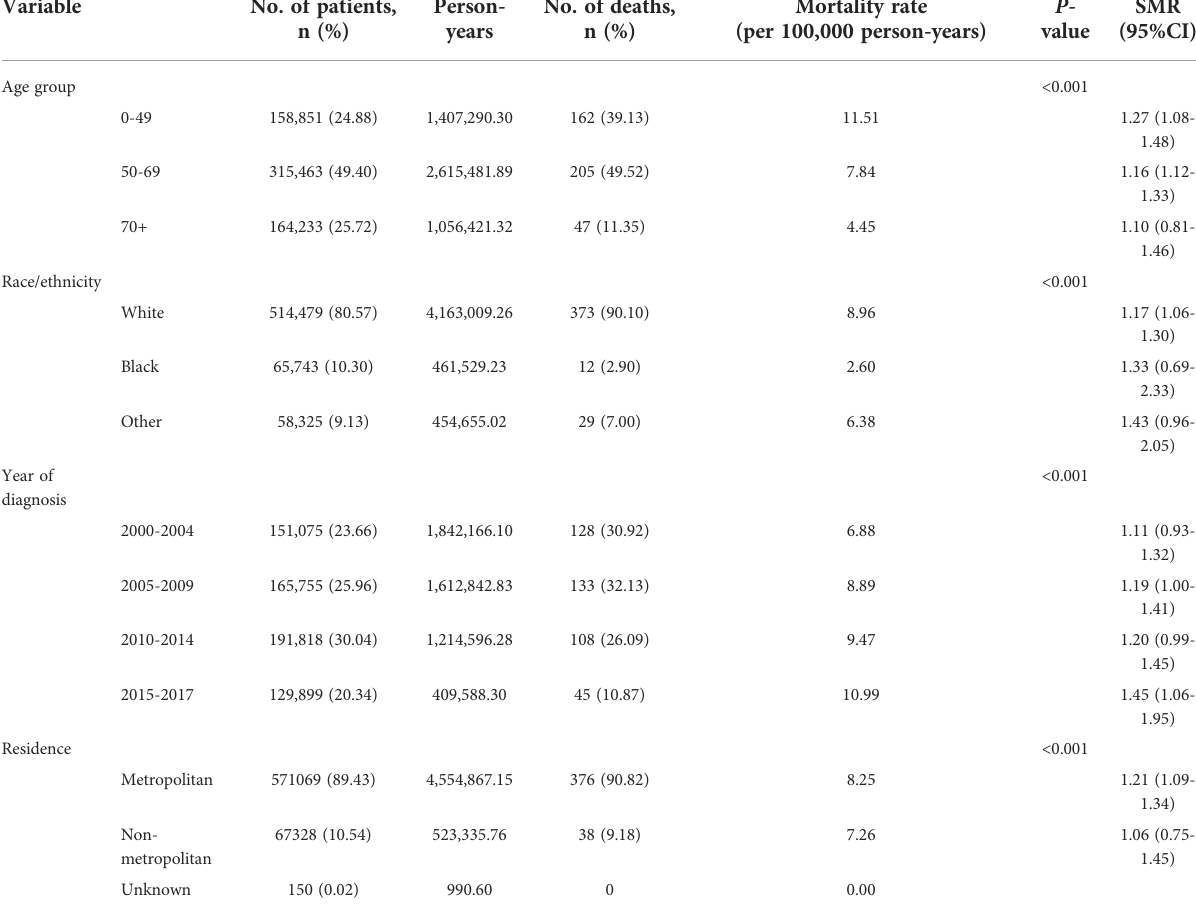
TABLE 1 Suicide rates, according to demographic and clinical characteristics, female breast cancer survivors, 2000 to 2017. Variable No. of patients,